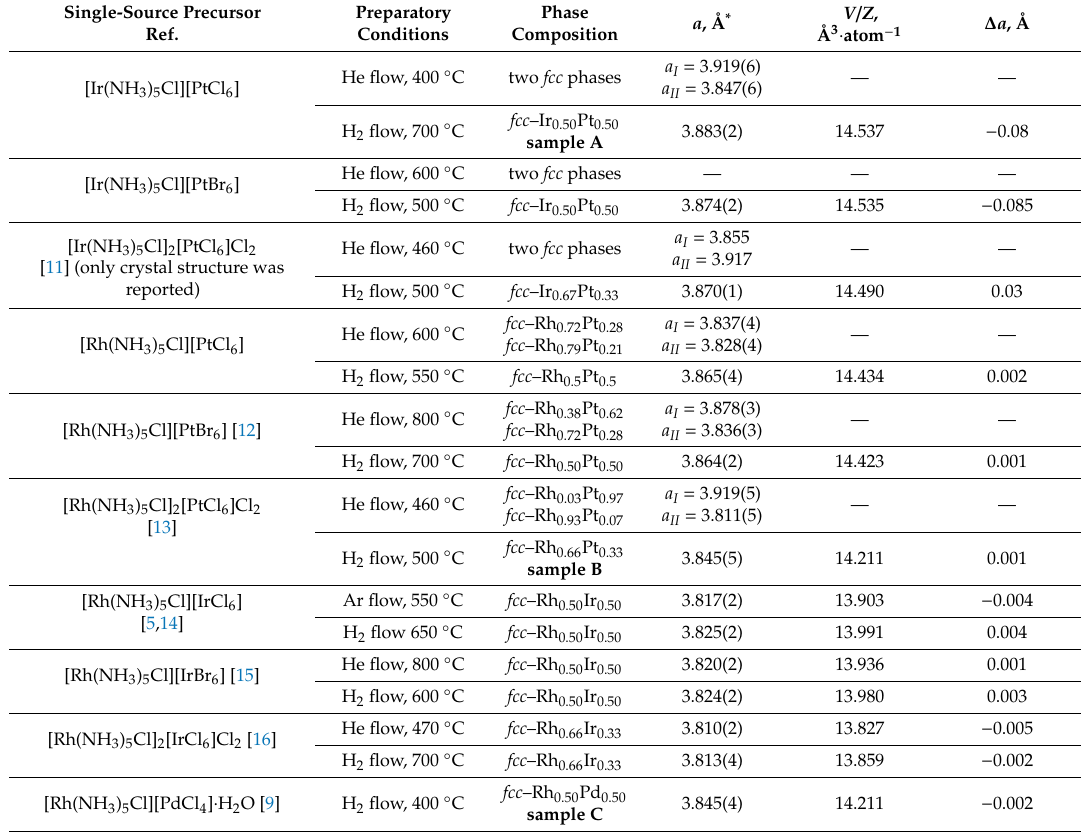
Table 1. Preparatory conditions and crystallographic characteristics for fcc -structured Rh, Ir, Pt and Pd binary alloys. Single-Source Precursor